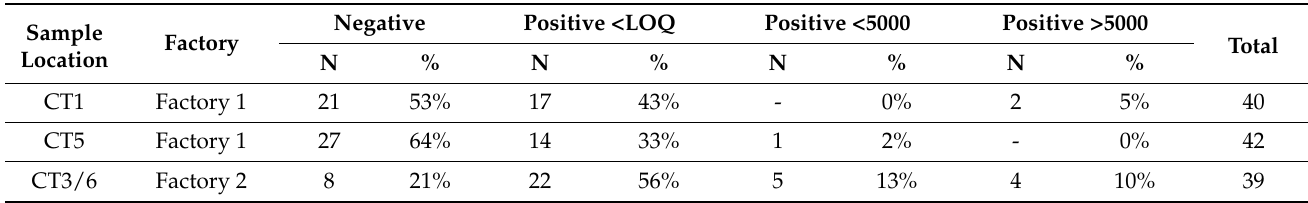
Table 2. Legionella spp. qPCR data for cooling